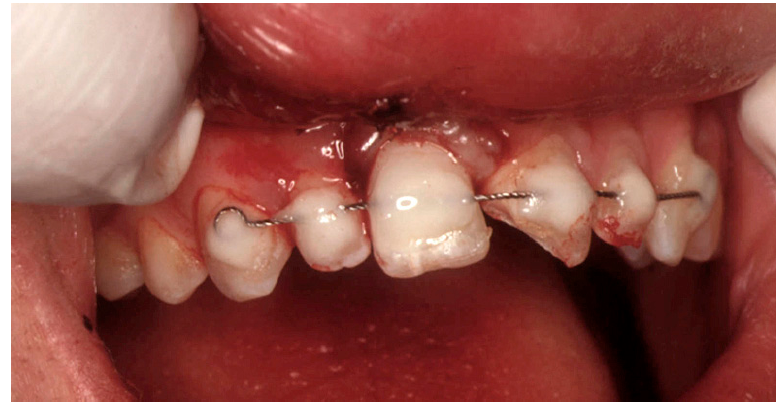
Figure 3. Intraoral view after replantation and functional splinting of tooth 11.